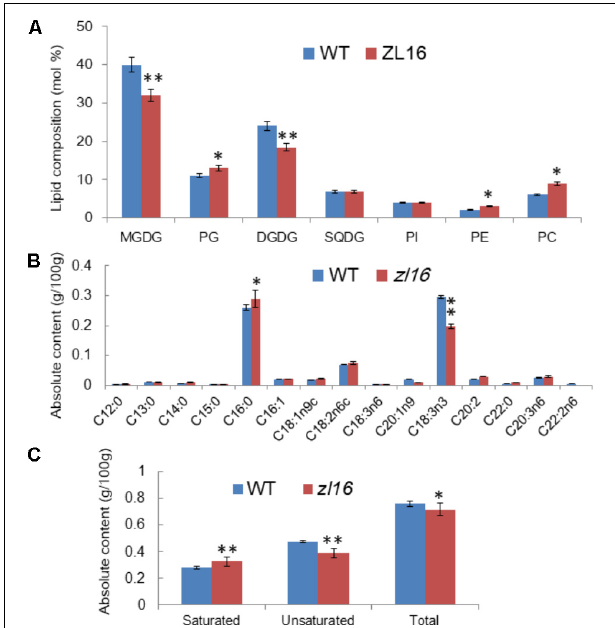
FIGURE 10 | Determination of fatty acids in wild-type (WT) and zl16 seedlings. (A) Comparison of polar lipid classes (percentage of total polar glycerolipids analyzed) in leaves of the wild type and zl16 mutant. The bars indicate means ± SD of three measurements. MGDG, monogalactosyl-diacylglycerol; DGDG, digalactosyl-diacylglycerol; PC, phosphatidylcholine; PE, phosphatidylethanolamine; PG, phosphatidylglycerol; PI, phosphatidylinositol; SQDG, sulfoquinovosyldiacylglycerol. (B) The content of each fatty acid in wild-type and zl16 mutant seedlings. (C) Comparison of saturated and unsaturated fatty acids in wild-type and zl16 mutant seedlings. n = 6. Asterisks indicate the significance levels according to Student’s t -test: ∗ P < 0.05, ∗∗ P <